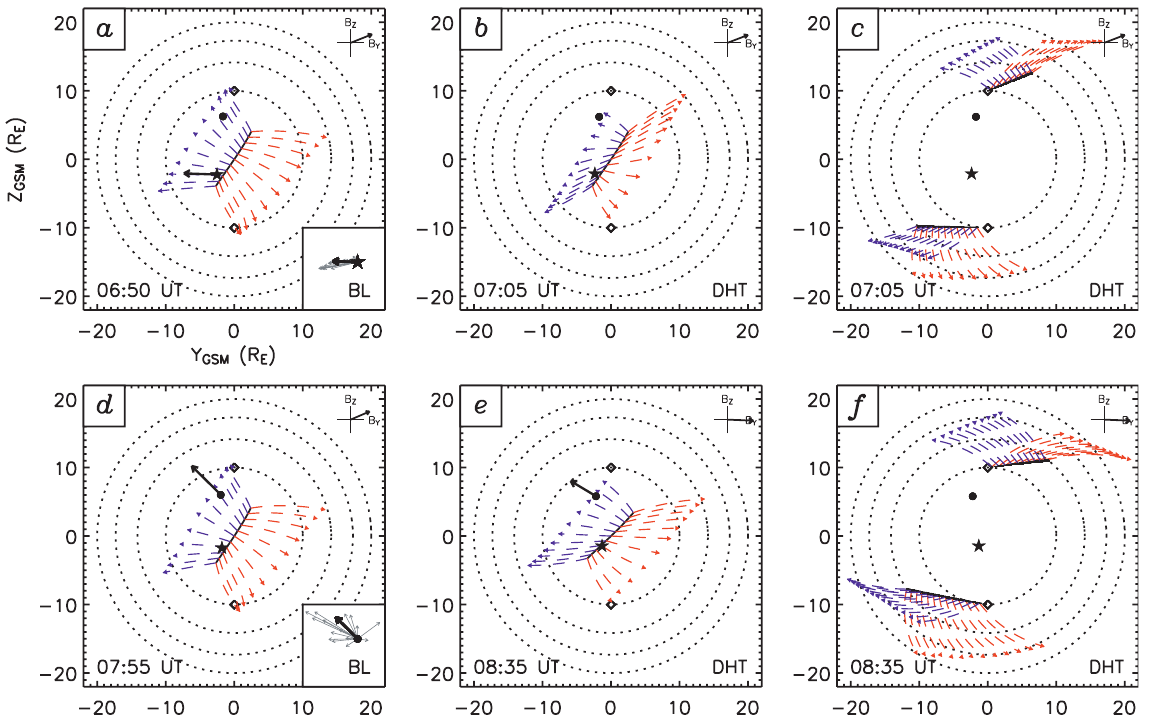
Fig. 12. Results of the Cooling model showing boundary layer plasma flow and open flux tube motion at the time of Double Star (a–c) and Cluster (e–f) observations. Each panel presents a view of the magnetopause as seen from the Sun. The IMF clock angle used for each computation is indicated in each panel and corresponds to the time shown. An X-line (solid black line) and flow streamlines showing either boundary layer motion (in panels marked “BL”) or open flux tube motion at the de Hoffman-Teller velocity (in panels marked “DHT”) are overlaid - dashed blue (red) vectors indicate motion corresponding to flux tube attached to the Northern (Southern) Hemisphere. The locations of the Cluster and Double Star satellite are shown by circular and star symbols, respectively, and experimentally-determined parameters overlaid as described in the text. In the panels presenting averaged observed boundary layer flow vectors (a and d), the individual measurements used in the averaging calculation are shown in the inset